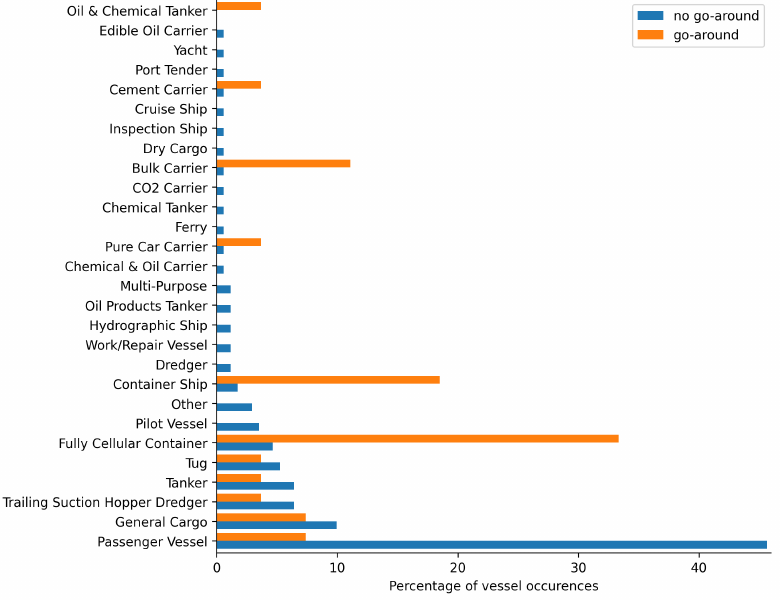
Figure 3. Distribution of largest passing vessel type during North-East approach with (total 27) and without (total 171)